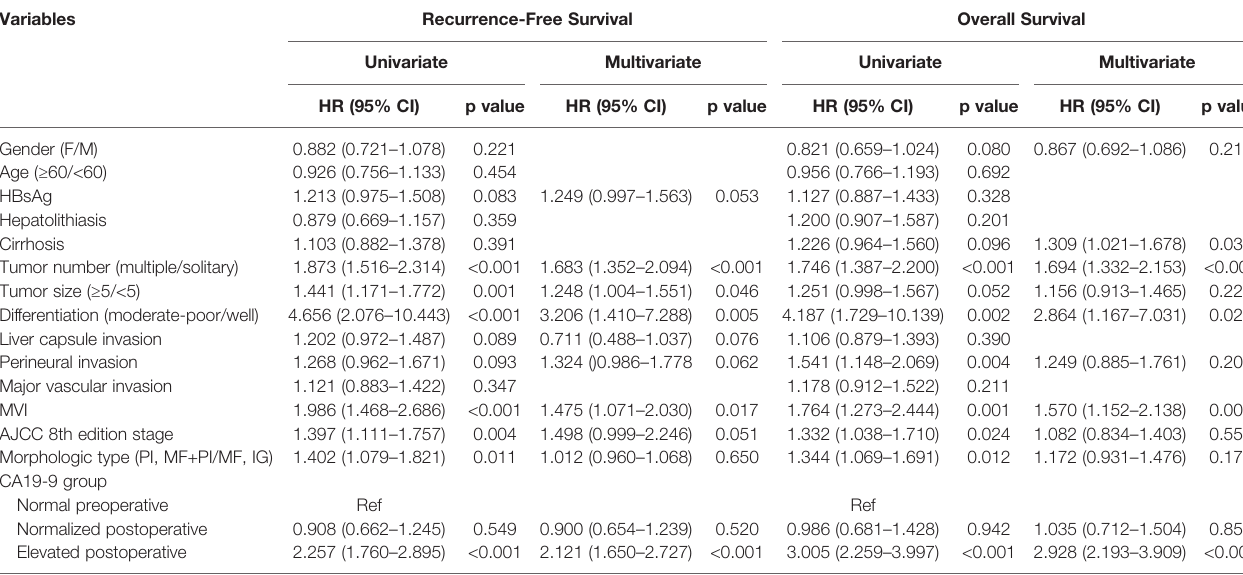
TABLE 2 | Prognostic factor analysis for recurrence-free survival and overall survival.